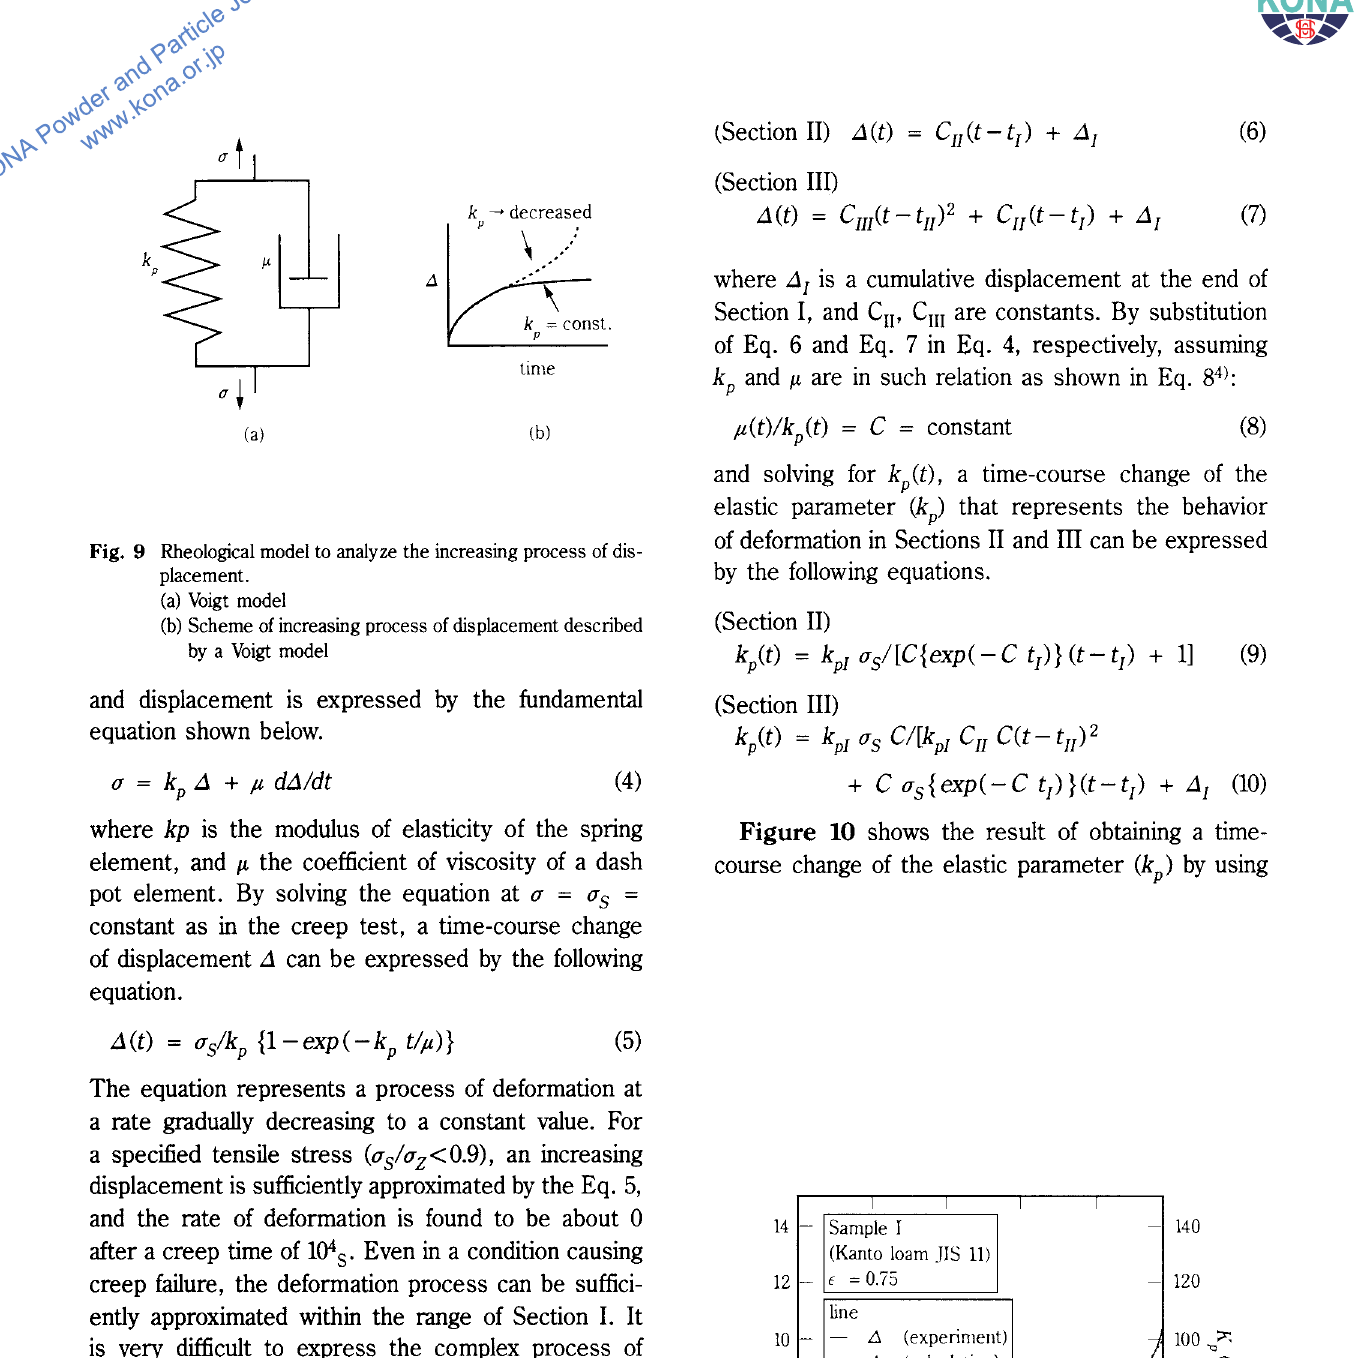
Fig. 10 Examples of fitted and calculated results of increasing and changing process of dis placement and elastic parameter in Voigt model.